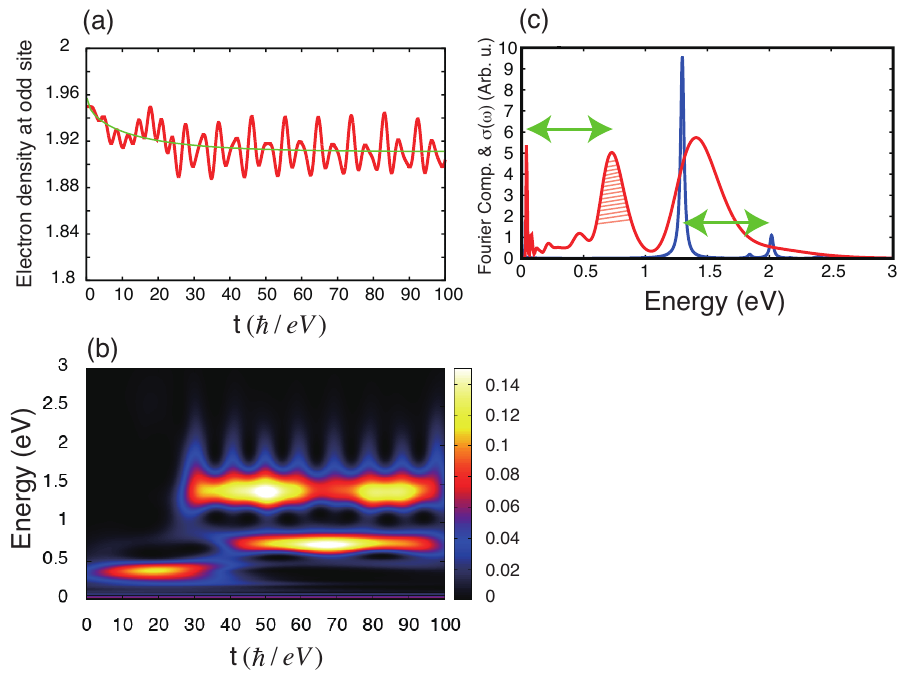
Figure 5. ( a – c ) Same as Figure 3, but for ∆ ef f = 0.70 eV and ¯ h ω c = 1.2